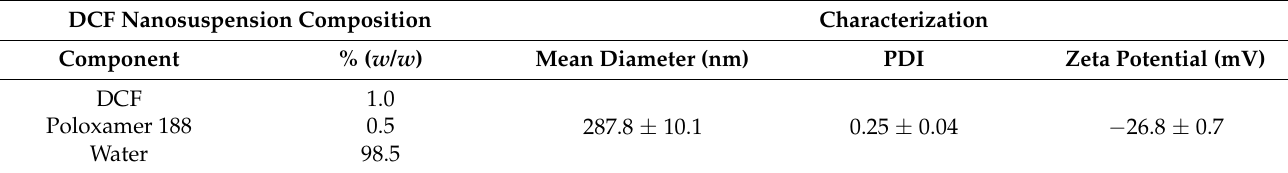
Table 1. Quali-quantitative composition and characterization of DCF